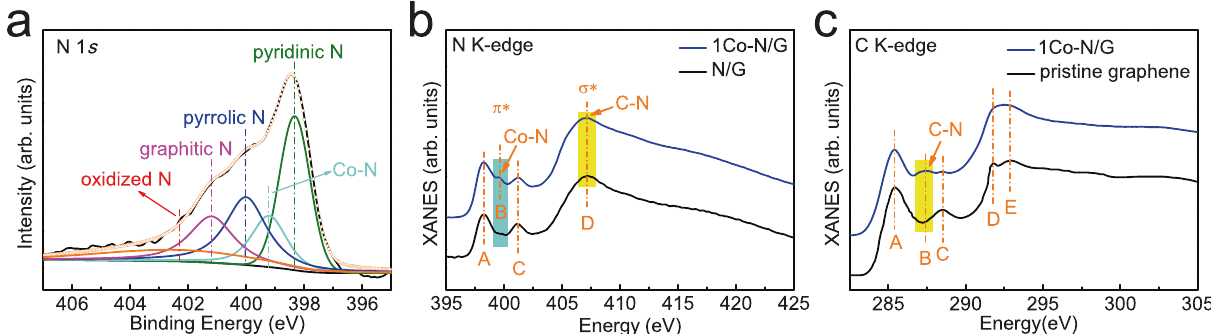
Fig. 2 Bonding con fi guration of Co atoms. a N 1 s XPS spectrum of 1Co-N/G nanosheets. b N K-edge XANES spectra of 1Co-N/G and N/G nanosheets.